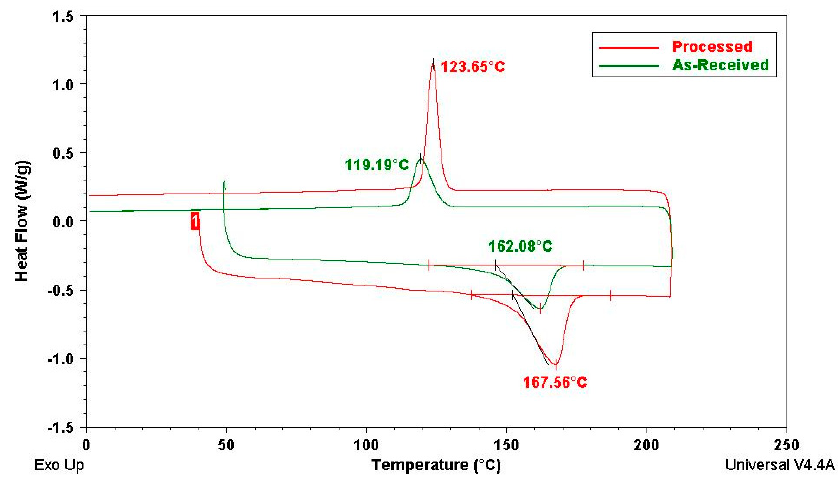
Figure 7. Heating and cooling DSC curves for the as-received shred and processed plates.